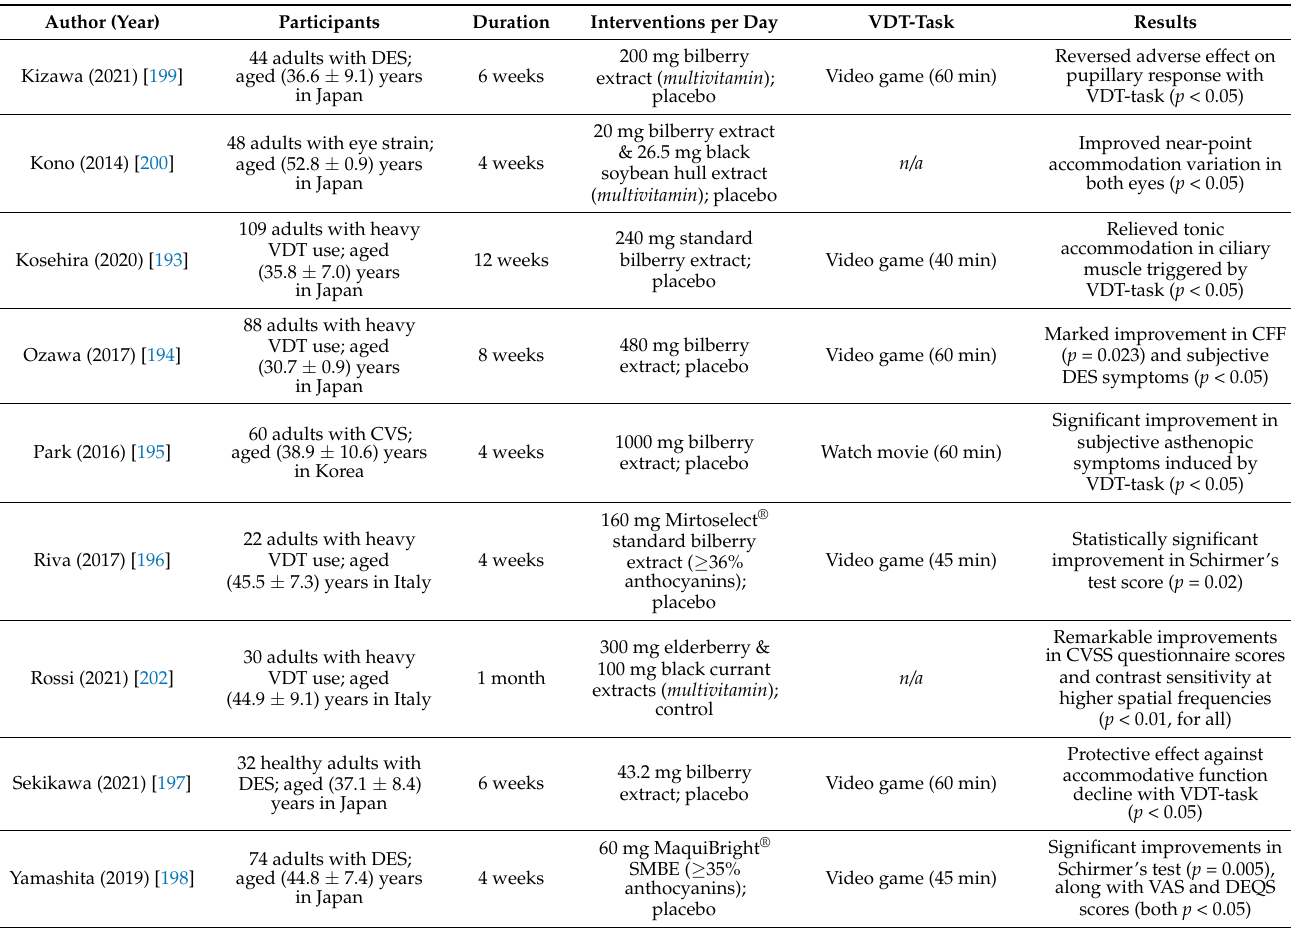
Table 2. Characteristics of the randomized clinical trials using anthocyanin